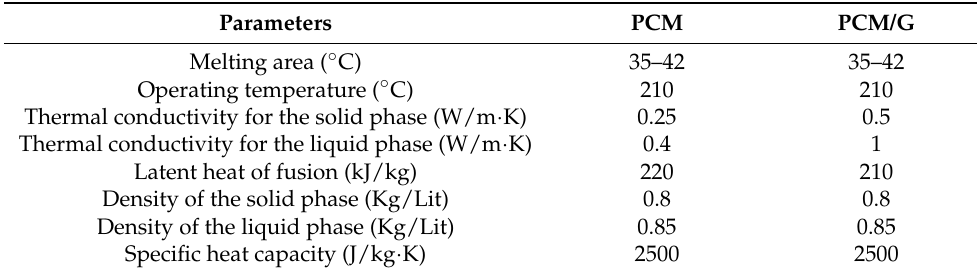
Table 2. The main features of the PCM and PCM/graphite.